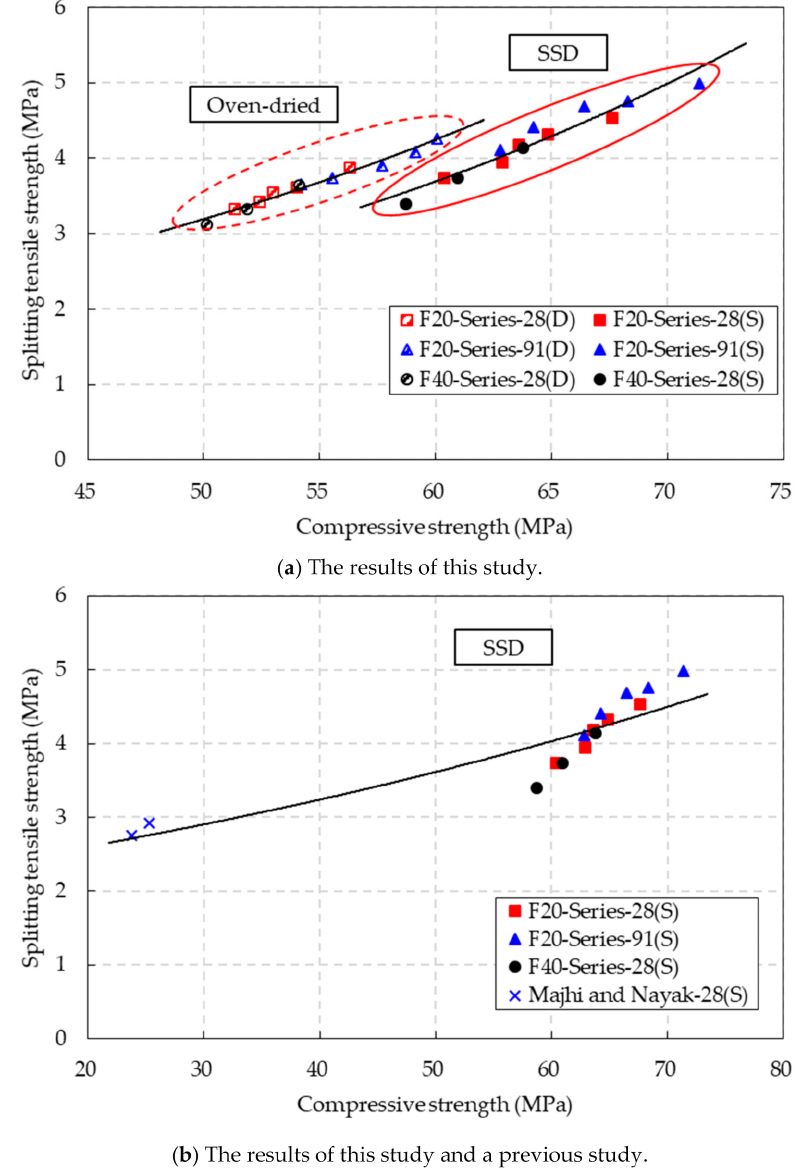
Figure 11. Relationship between the splitting tensile strength and compressive strength of the CBA